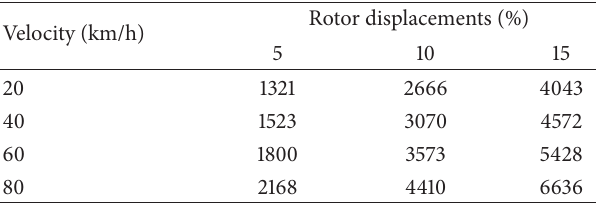
Table 1: SRM vertical force (unit: